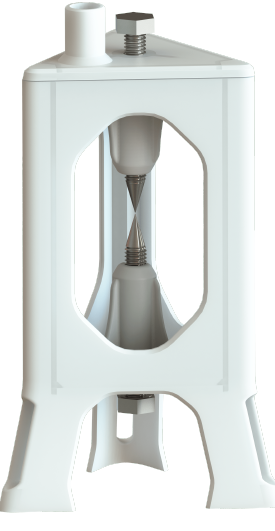
Figure 5. Pulsed plasmolysis cell